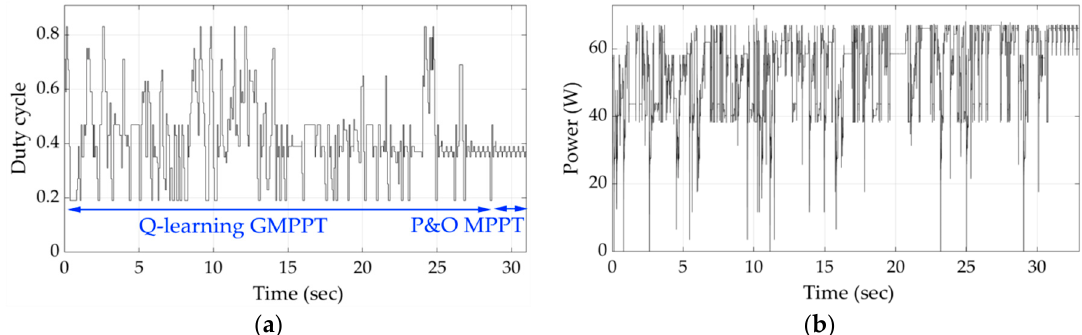
Figure 9. Results during execution of the proposed Q-learning-based GMPPT process for shading pattern 2: ( a ) duty cycle versus time and ( b ) PV array output power versus time.